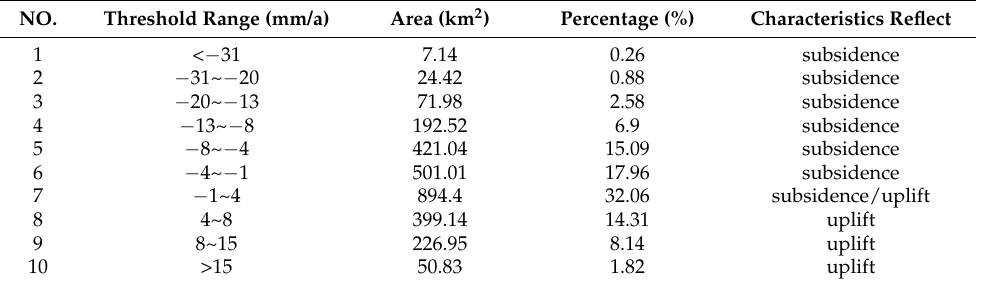
Table 2. Statistics of InSAR surface deformation anomaly information in Yongping County (ascending).